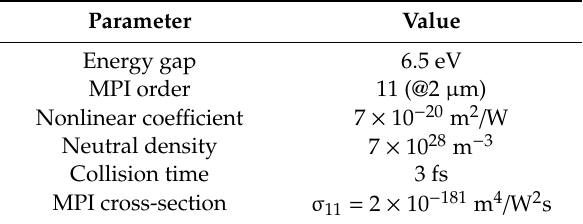
Table 2. Nd:Y 3 Al 5 O 12 (Nd:YAG) parameters used for UPPE simulation. Parameter